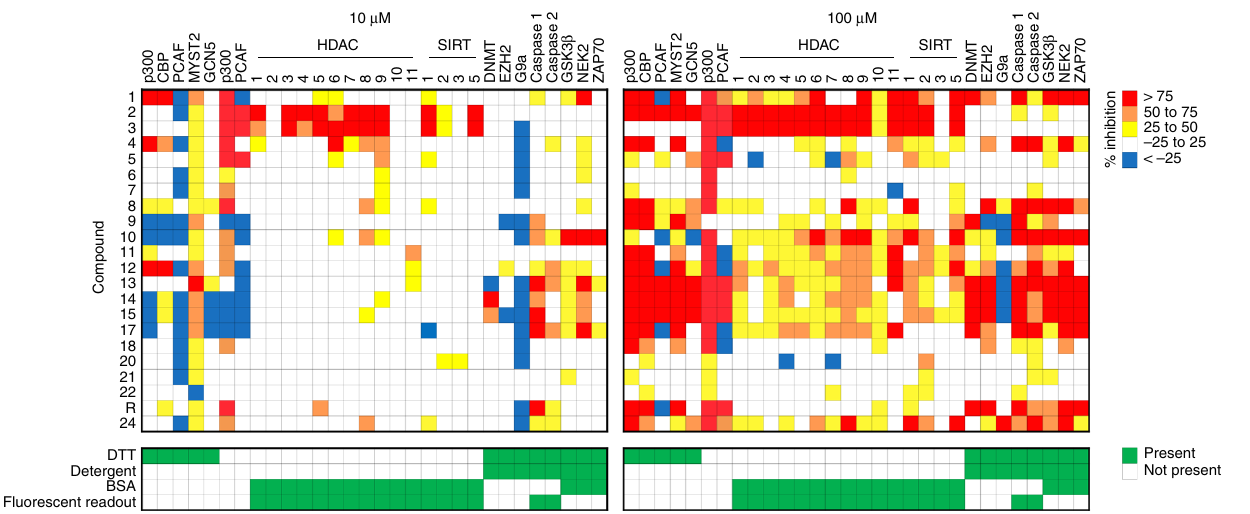
Fig. 3 Reported HAT inhibitors modulate multiple targets at concentrations common in biochemical and cell-based assays. Note compounds were tested vs. p300 and PCAF in both the presence and absence of DTT. Bottom panels denote assay condition details. Data are expressed as mean from one experiment performed with two technical replicates. R